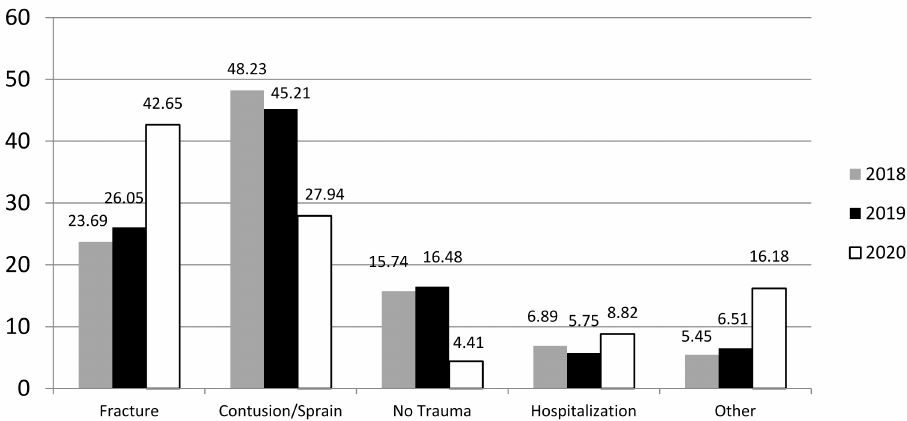
Figure 1. Comparison between 2018, 2019 and 2020 in terms of type of injury and need for hospital- ization (in